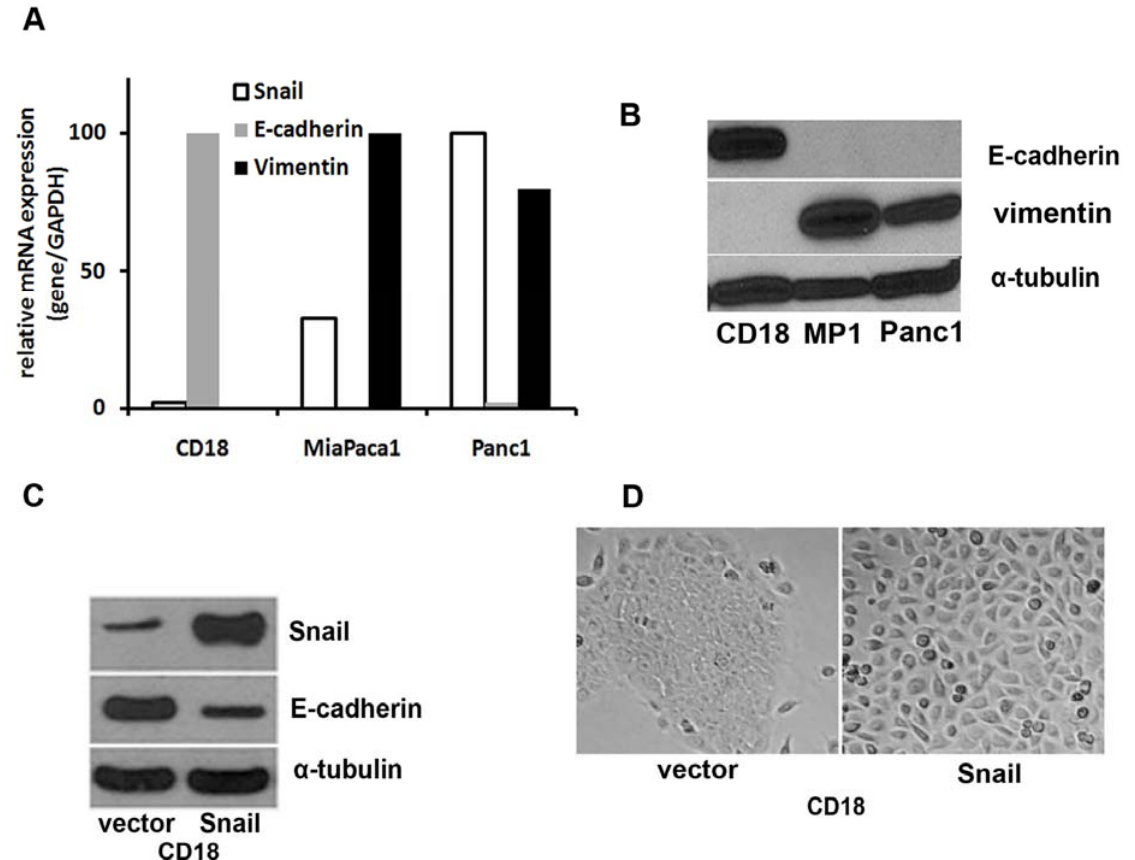
Figure 2. Snail expression is associated with decreased E-Cadherin expression, increased vimentin, and a fibroblast-like phenotype. ( A ) Snail, E-cadherin, and vimentin mRNA expression as determined by qRT-PCR, normalized to GAPDH, in three pancreatic cancer cell lines, HPAF-II/CD18 (CD18), MiaPaCa-1 (MP1), and Panc1. ( B ) E-cadherin expression inversely correlates with vimentin expression in three pancreatic cancer cell lines as determined by Western blot. ( C ) Expression of Snail and E-cadherin, as determined by Western blot, in CD-18 pancreatic cancer cells induced to express either Snail or a control vector. ( D ) Growth architecture of CD-18 pancreatic cancer cells induced to express either Snail or a control